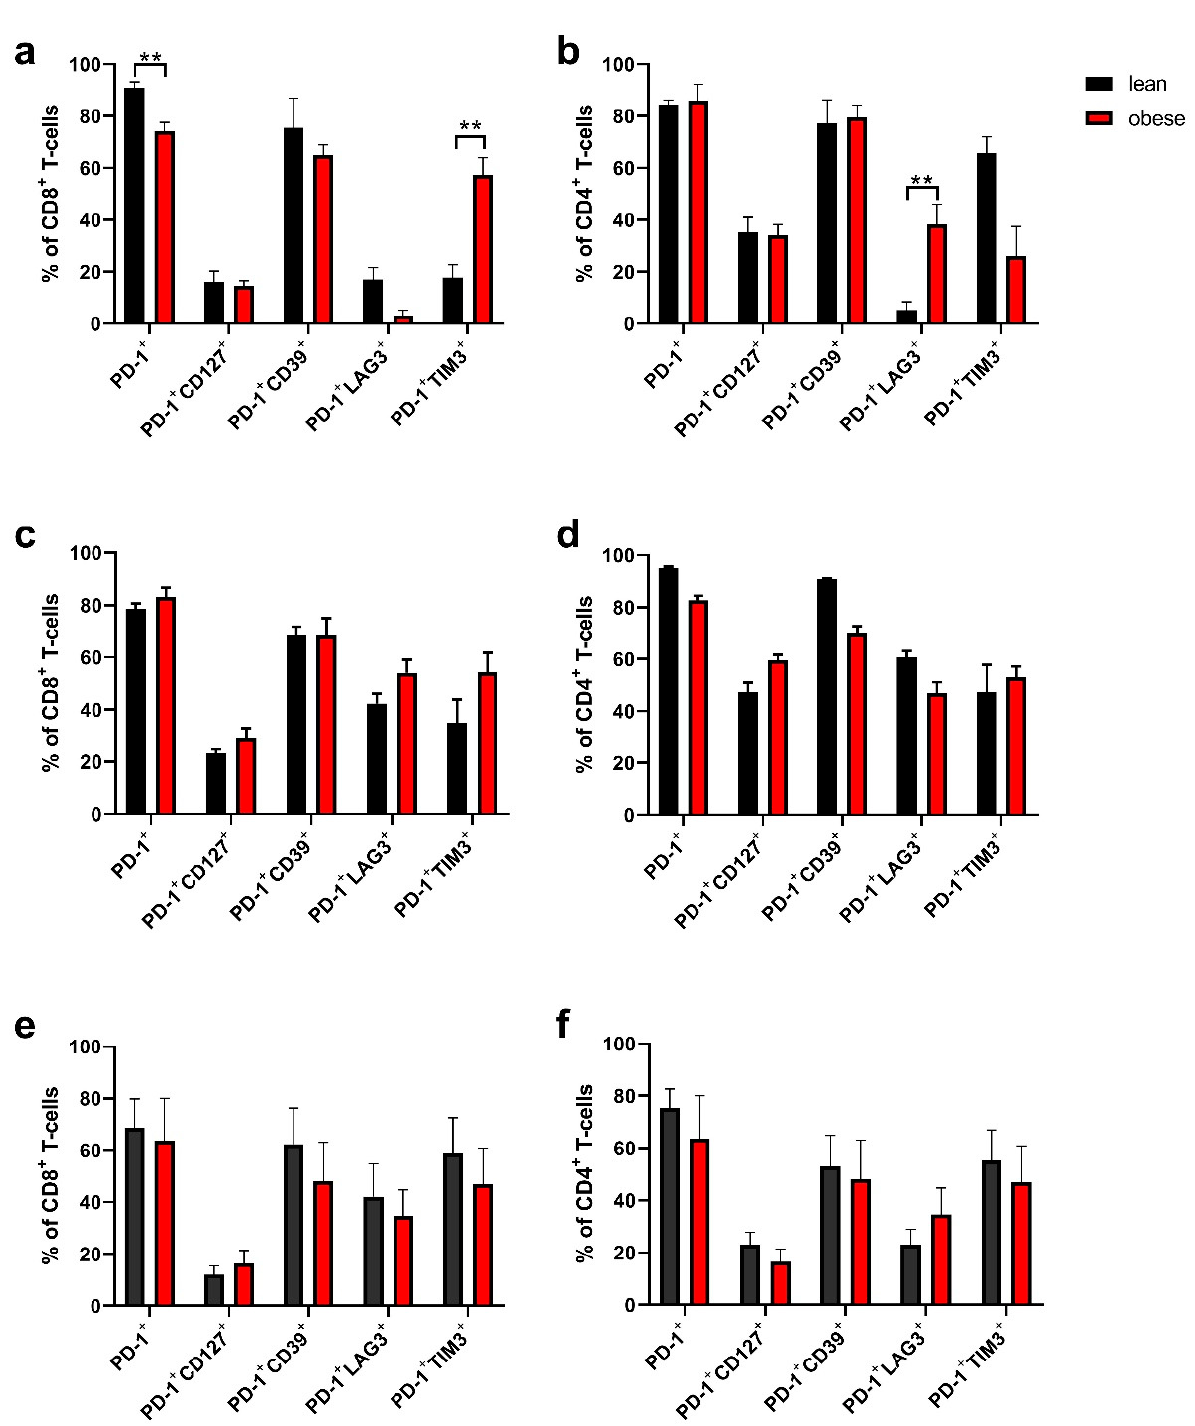
Figure 4. T-cell exhaustion of TILs in BC and CRC tumours in obese and lean mice. Tumours at 150 mm 2 from ( a , b ) C57mg cells; ( c , d ) EO771.LMB cells and ( e , f ) MC38 cells were extracted from mice, cells were isolated using physical dissociation and purified using a Ficoll-Paque gradient. Cells were then stained for flow cytometry analysis. Results show the mean + STD of 5 mice/group. Statistical differences were determined by using an unpaired student’s t -test. ** p < 0.01.